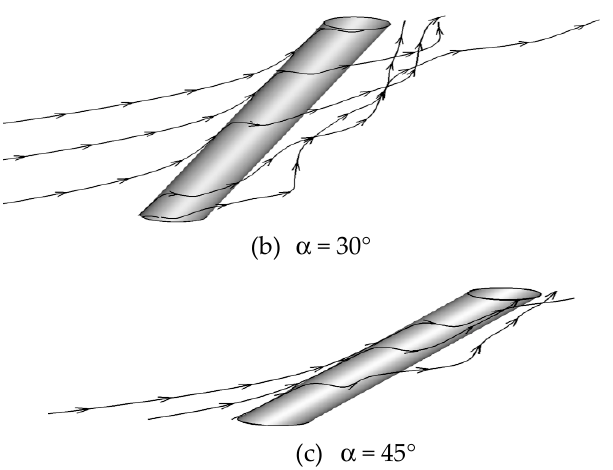
Figure 9. Streamline development for three yaw angles under periodic boundary condition.